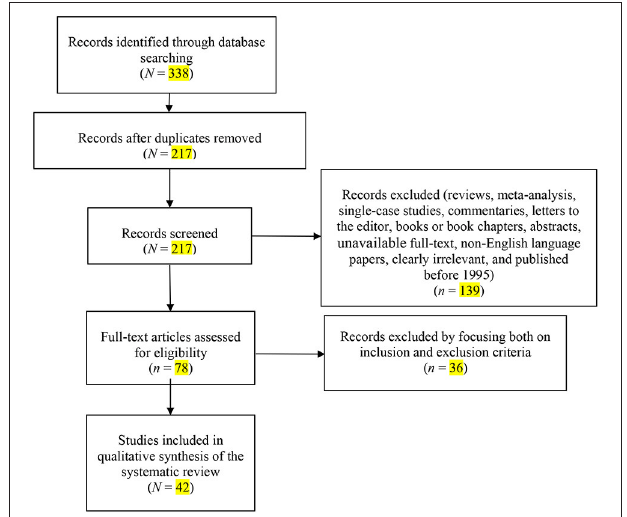
FIGURE 1 | PRISMA Flowchart of the systematic